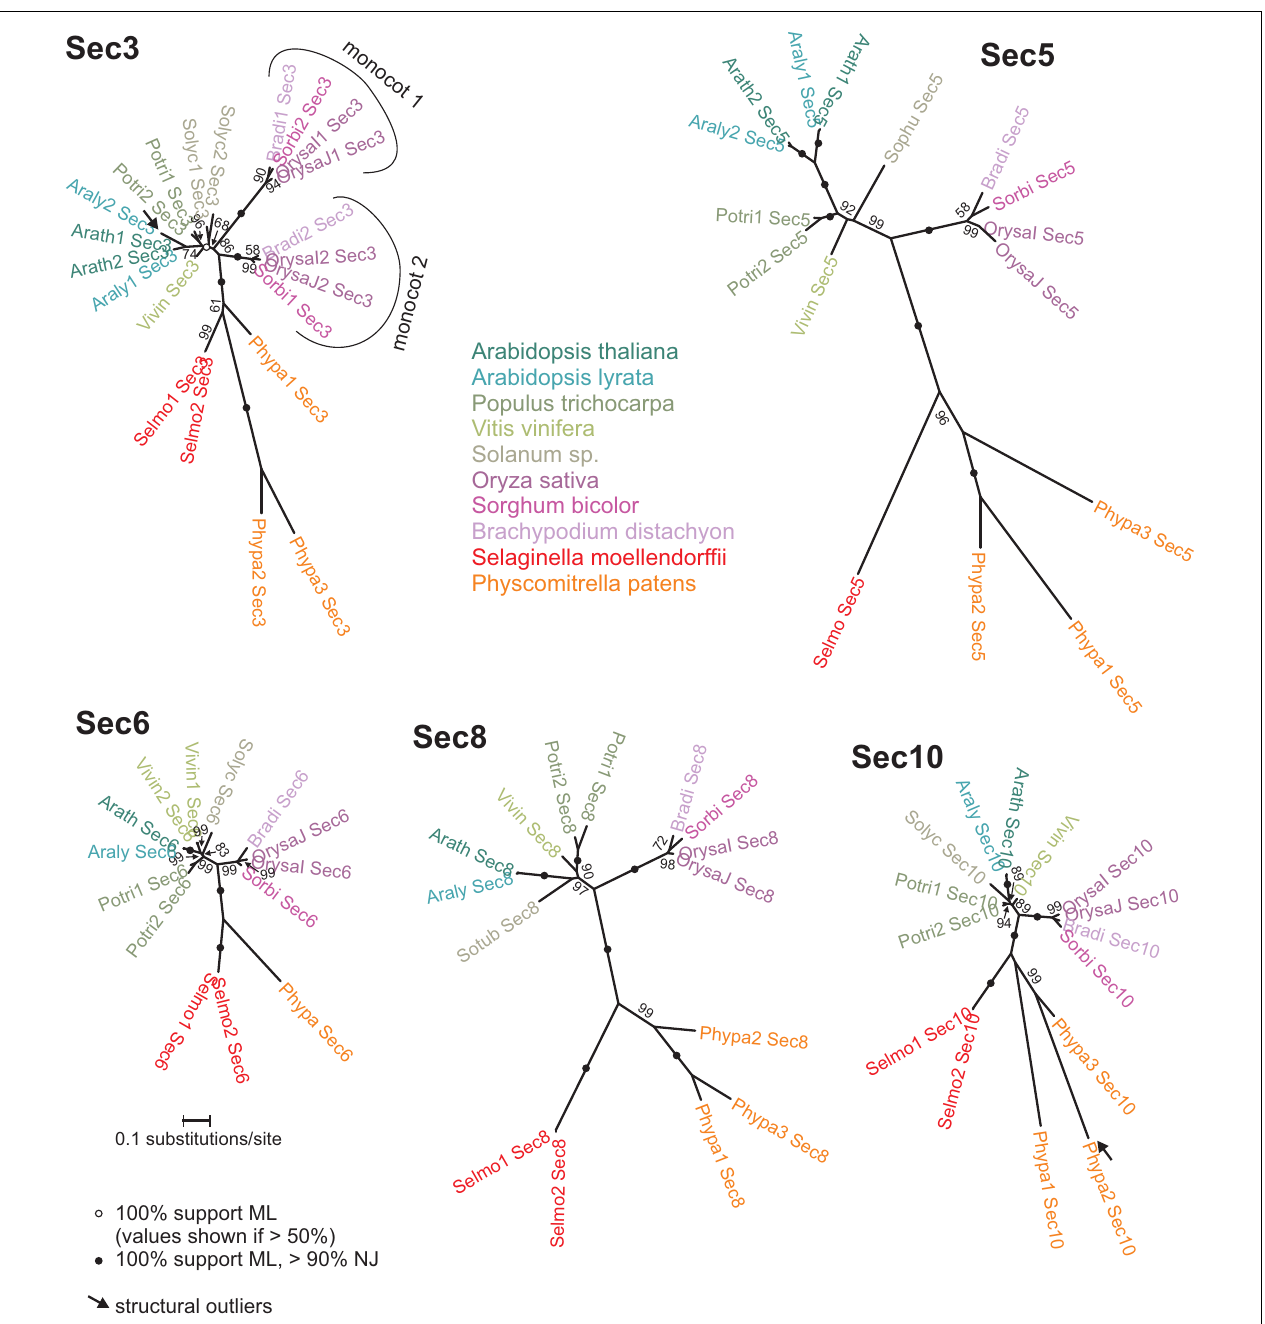
support by both ML and NJ algorithms are marked by black dots. Arrows denote “structural outliers,” i.e., sequences deviating from the standard domain organization of typical representatives of the protein family. All trees are at the same